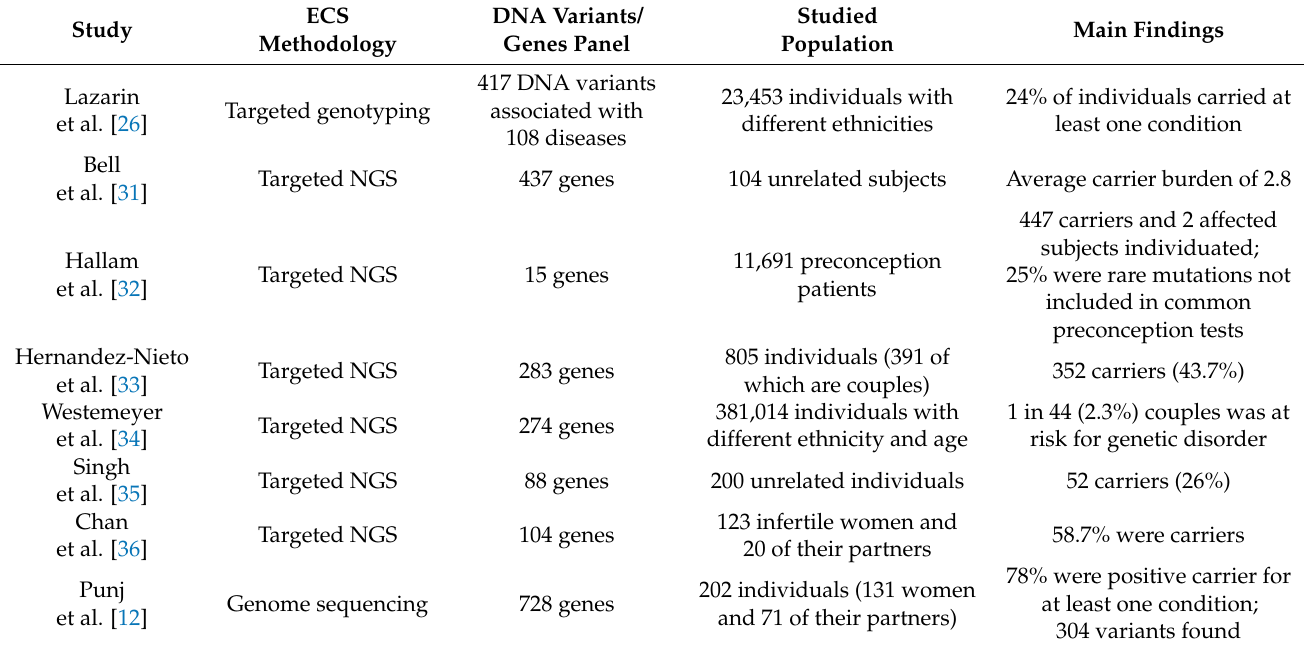
Table 1. Comparative table reporting the study design and the main findings of the cited ECS